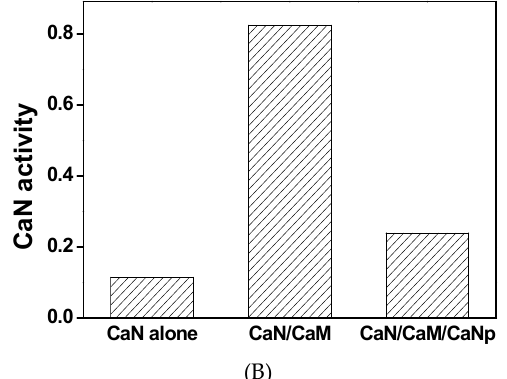
Figure 3. The phosphatase activity of CaN activated by the presence of recombinant CaM. ( A ) The hydrolysis of a fluorogenic substrate, 4-methylumbelliferyl-phosphate (4-MUP) by CaN was monitored spectrofluorometrically with excitation and emission wavelengths at 365 nm and 445 nm, respectively. The fluorescence intensity was converted to the concentration of the product, 4-MU using a calibration curve as described in Materials and Methods. The hydrolysis time curve of 4-MUP assayed by CaN alone, CaN with equimolar CaM, and CaN with equimolar CaM and CaNp were shown in green, red, and black respectively; ( B ) The average specific activity of CaN against 4-MUP in the absence or presence of CaM and CaNp. The averaged specific phosphatase activity of CaN was calculated over the time period of 60 min, as µmol 4-MU produced per hour per µg CaN.